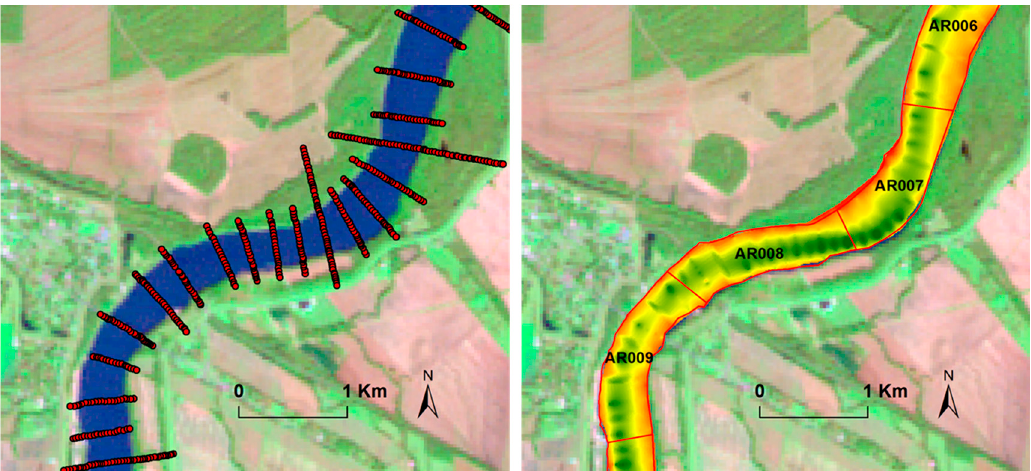
Figure 2. Left : Raw single beam survey data used to develop the riverbed digital elevation model (DEM). Right : DEM data were generated through interpolation for the uppermost 69-km Atchafalaya River. Each subreach represents a 1600-m (1-mile) long reach in bankfull width.